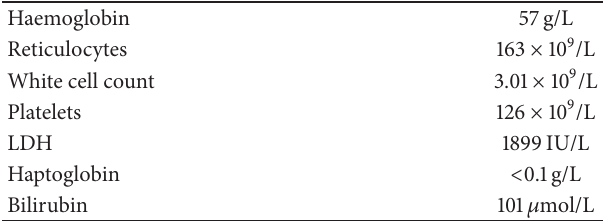
Table 1: Blood test results on